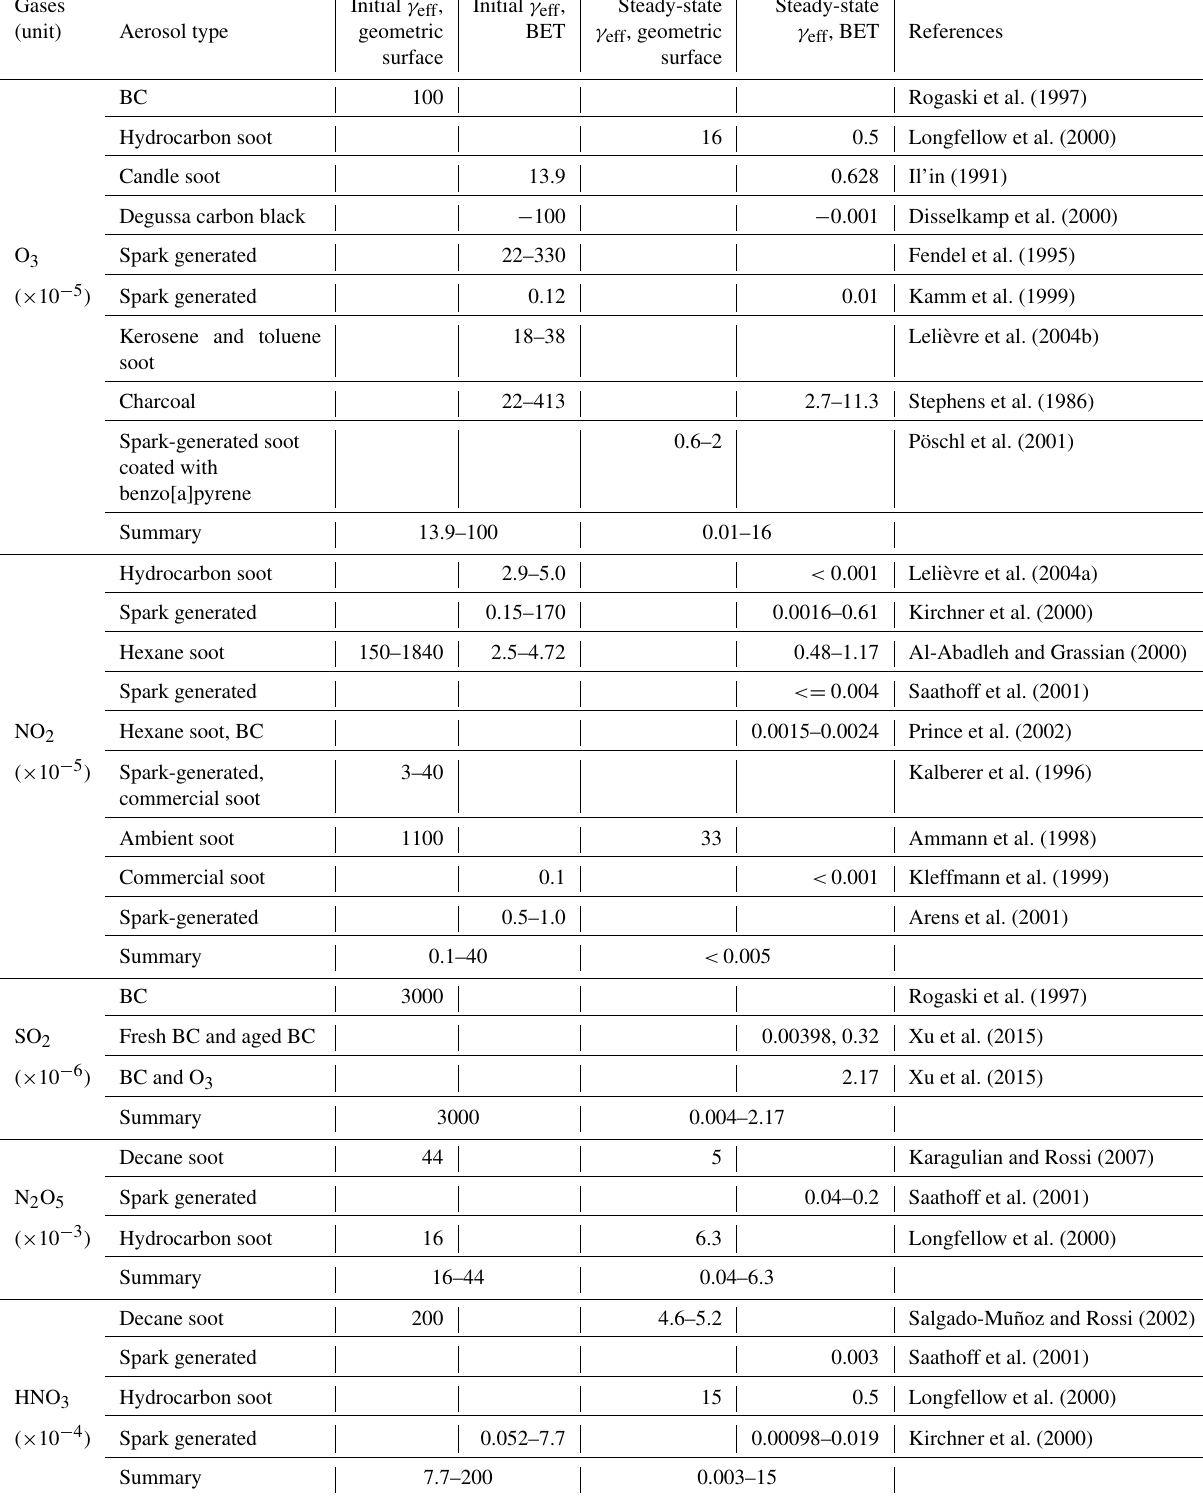
Table A2. Aerosol uptake coefficients ( γ eff ) for reactive gases on soot observed in laboratory experiments ( T = 298 ± 2K if not specified